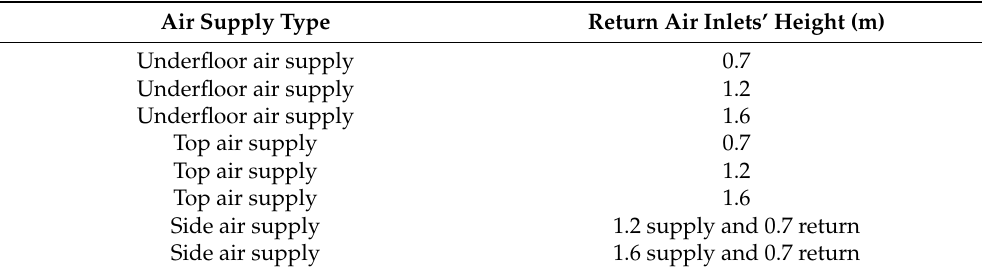
Figure 2. Schematic diagram of three air supply methods, in which the upper two return air outlets can be moved (( a ) Top supply side return; ( b ) Underfloor air supply side return; ( c ) Side supply side return, 1.2 m air supply and 0.7 m air return; ( d ) Side supply side return, 1.6 m air supply and 0.7 m air return), the orange arrow represents supply air, and the red arrow represents return air. Table 1. Experimental air organization form and the height of the supply air outlets and return air inlets.